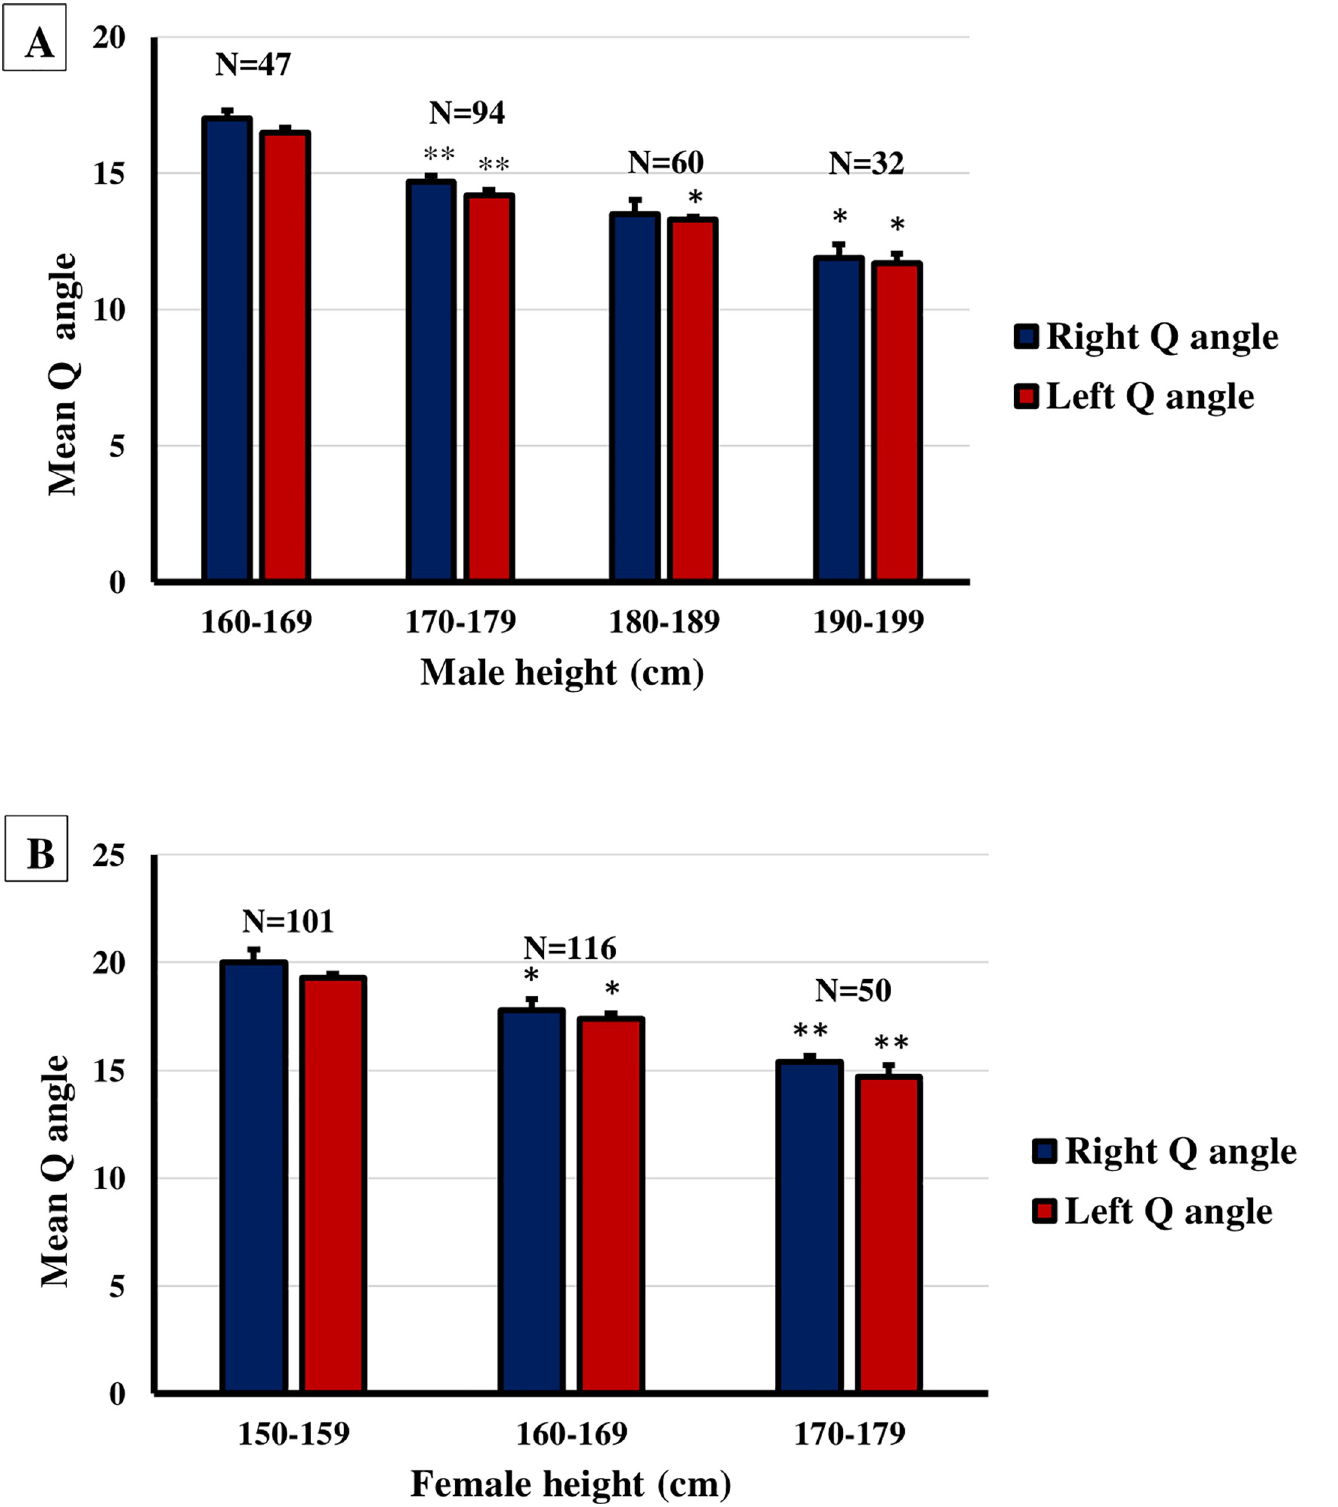
Fig 3. Variation of Q angle with respect to height in males (A) and females (B). A columnar representation for the relationship between the mean Q and the height of in males (A) and in females (B). Values are mean Q angle ± standard error (SE). There is a significant increase in Q angle as the condylar distance increases in both sides. � P < 0.05, �� P <